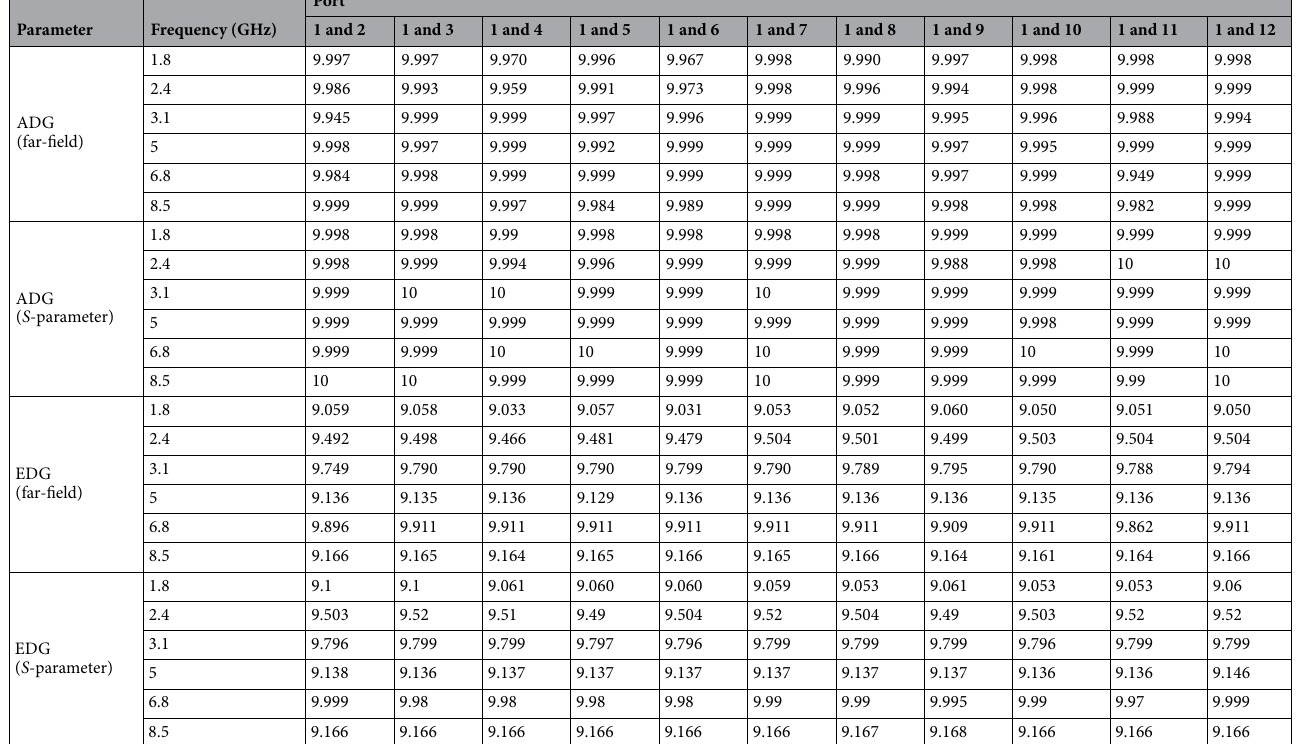
Table 3. ADG and EDG of the proposed antenna in relation to